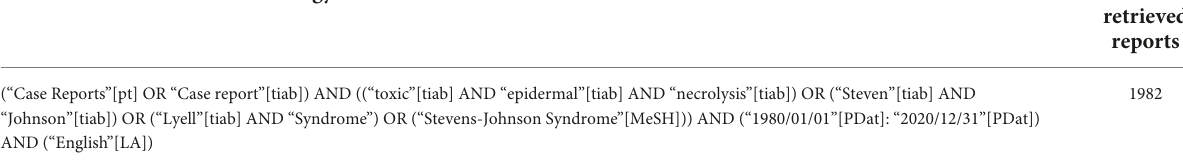
TABLE 1 PubMed/MEDLINE query to retrieve case reports related to Stevens-Johnson syndrome (SJS) and toxic epidermal necrolysis (TEN). PubMed/MEDLINE search strategy